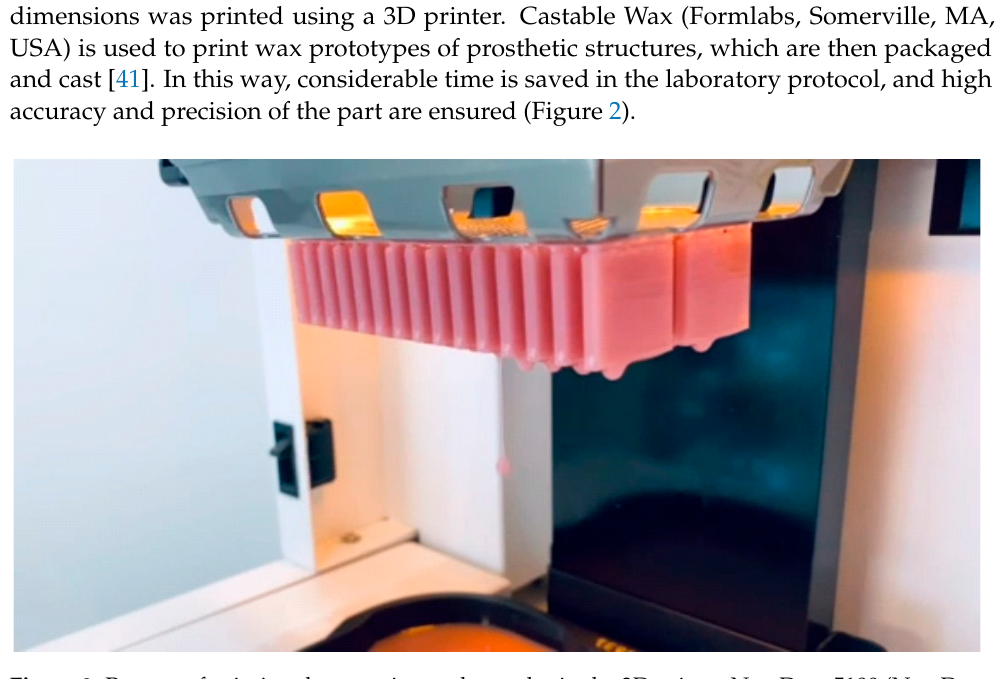
Figure 2. Process of printing the experimental samples in the 3D printer NextDent 5100 (NextDent, 3D Systems, Soesterberg, The Netherlands).